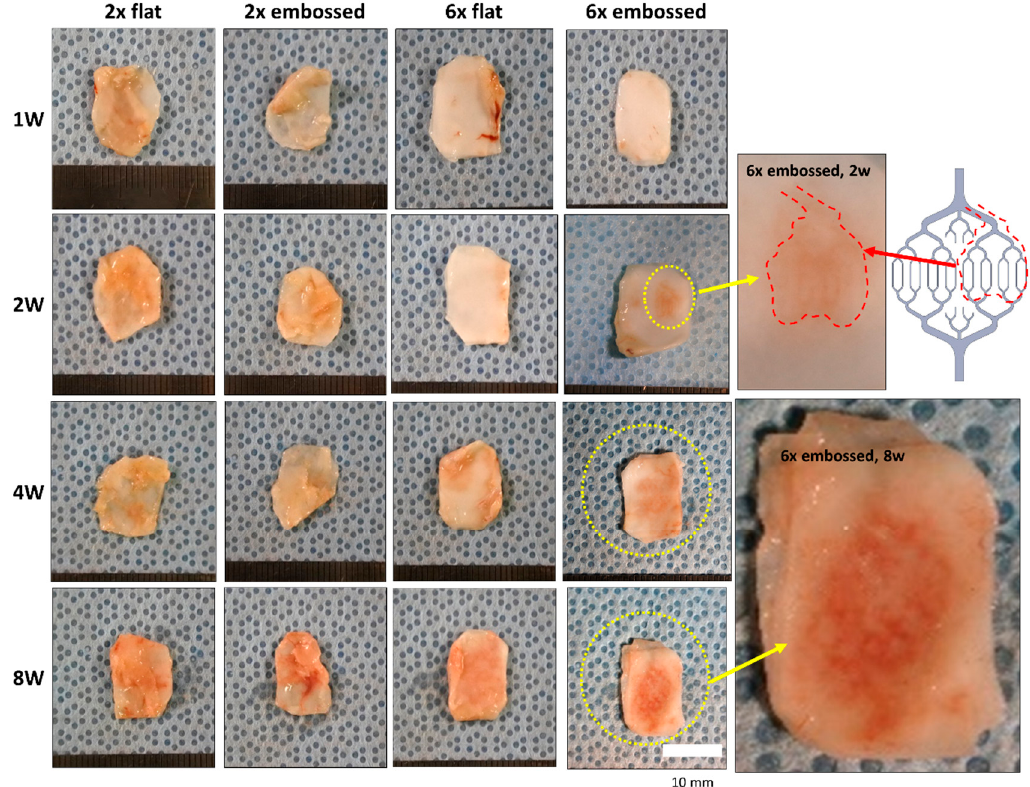
Figure 3. Embossed sheets after subcutaneous implantation in mice at one, two, four, and eight